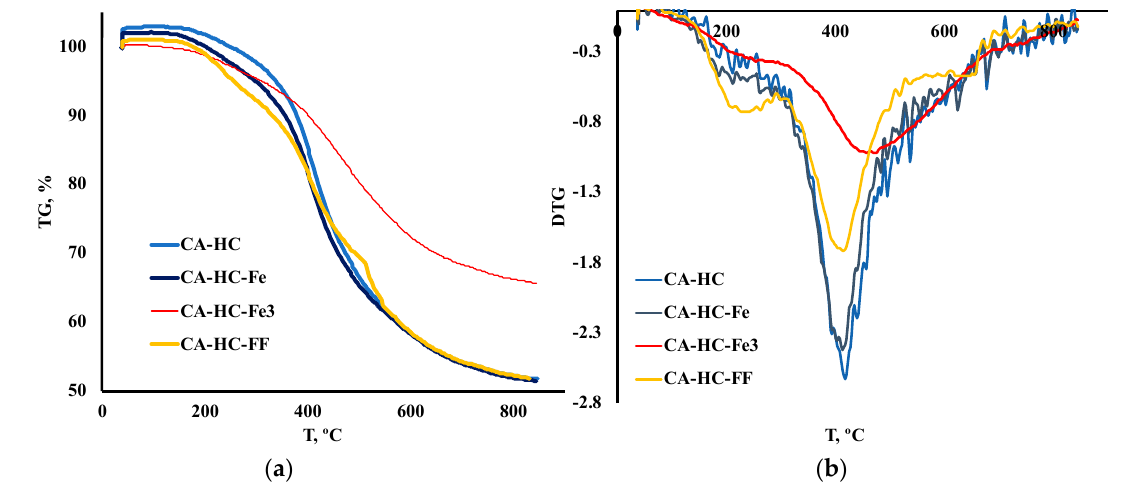
Figure 1. ( a ) TGA and ( b ) DTG degradation curves of HCs under inert conditions.